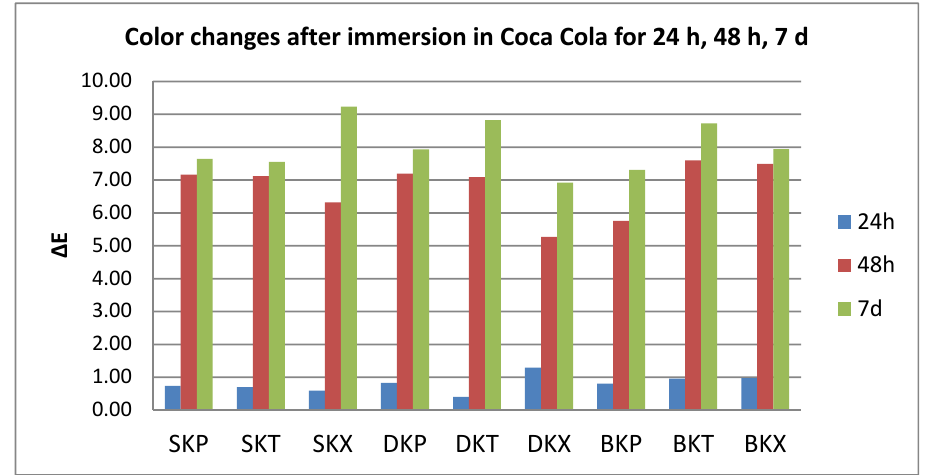
Figure 3. Mean values for ∆ E parameter for all the tested values after immersion in tea.